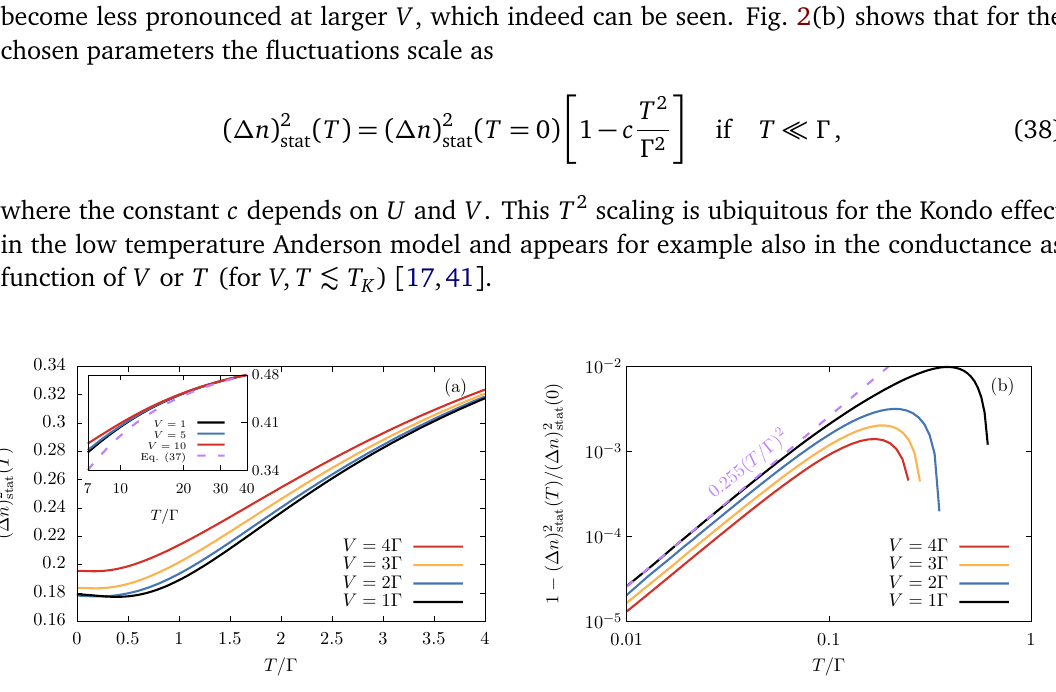
as function of temperature for stat